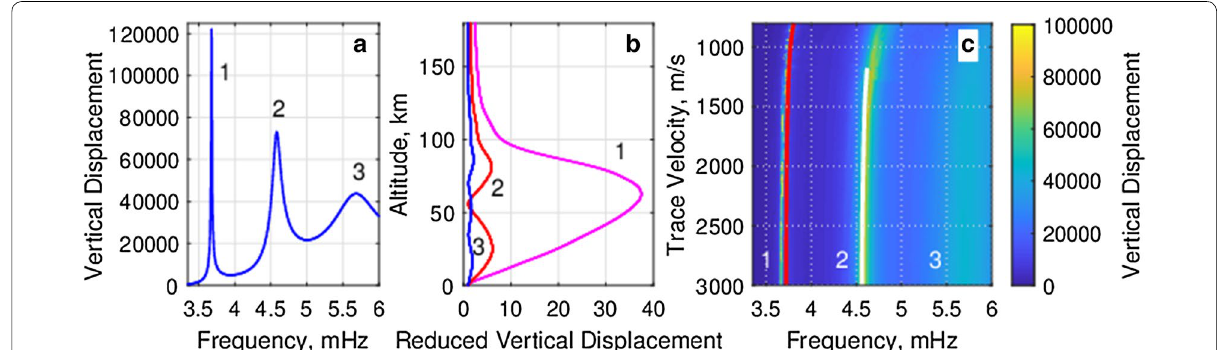
Fig. 3 Vertical displacements in a high-latitude atmosphere due to vibrations of its lower boundary. Same as in Fig. 1 but summer conditions over McMurdo (Antarctica) are assumed in all simulations. The WKB predictions for the frequencies of the first and second acoustic resonance are shown in (c) by the red and white lines,